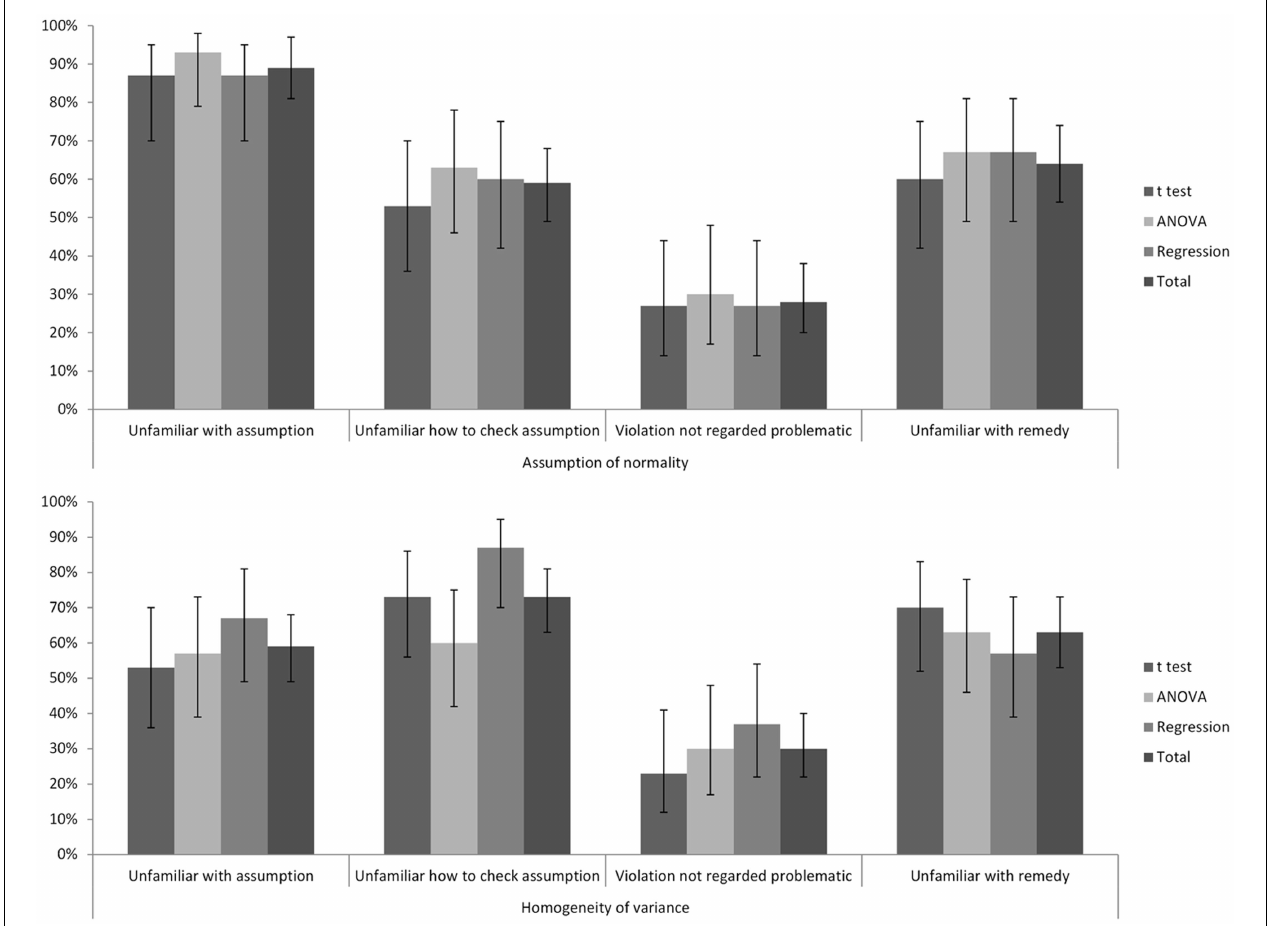
FIGURE 3 | Percentages of participants giving each of the explanations for not checking assumptions as a function of assumption and technique. Error bars indicate 95%